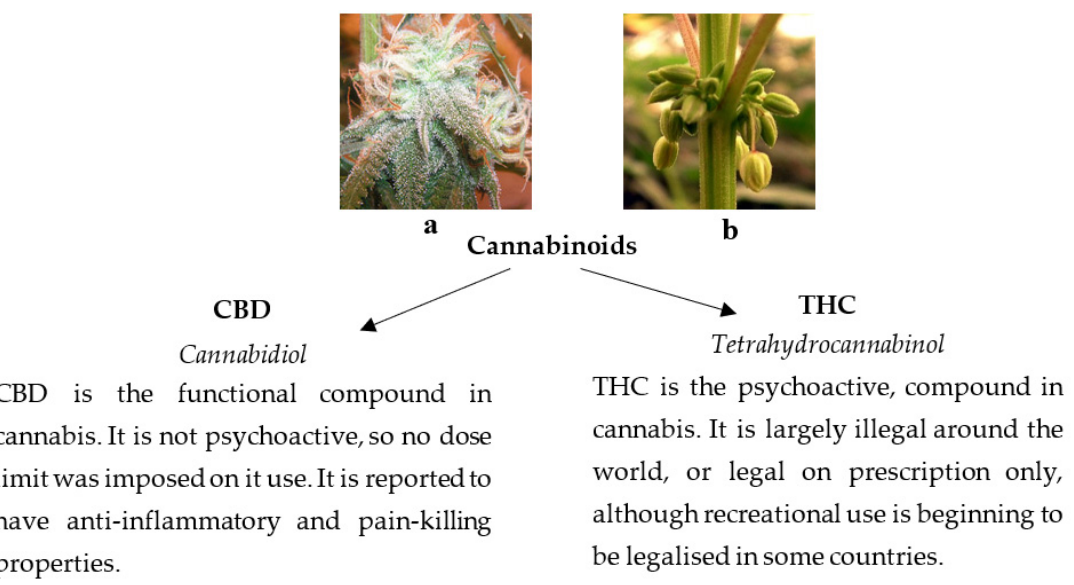
Figure 2. Main cannabinoids in cannabis sativa plant; ( a ) Female flower with visible trichomes; ( b ) male cannabis flower buds [11].